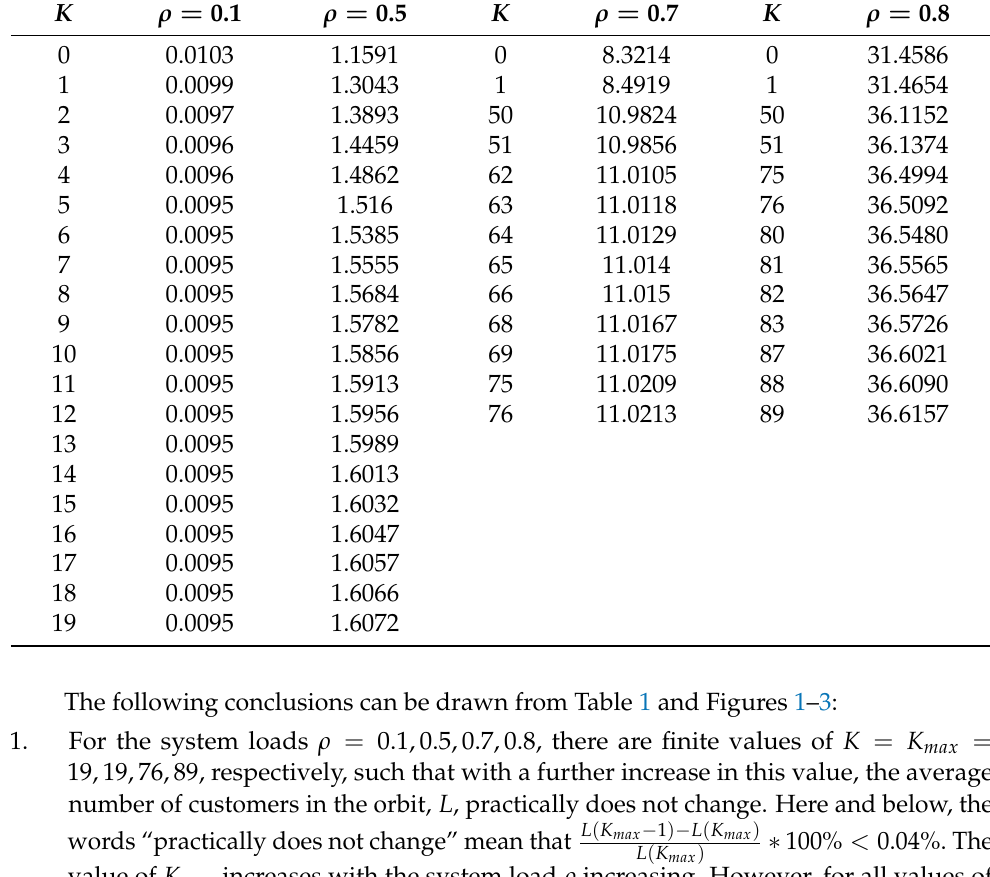
Table 1. The values of L for different values of ρ and K . K ρ = 0.1 ρ =